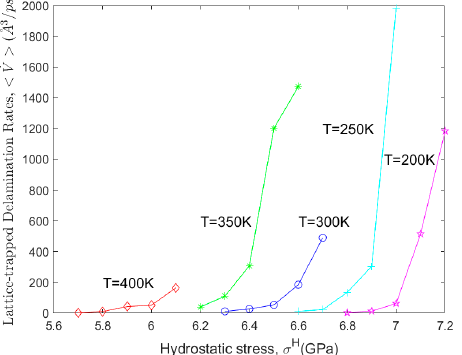
. V (cid:105) , as a function of hydro-